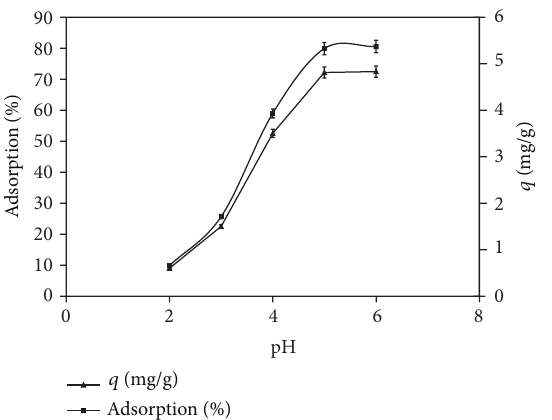
Figure 2: Effect of pH on lead biosorption by Ficus benghalensis L. for 20mg/L of metal and 0.1g/30 mL of biosorbent concentration.